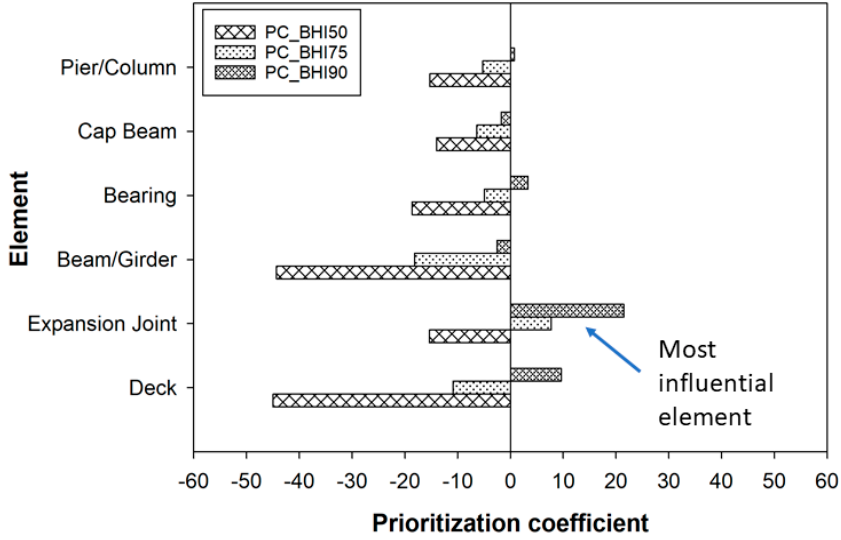
Figure 15. Prioritization coefficients in the ‘SO107’ group for BHI thresholds (50, 75, and 90).